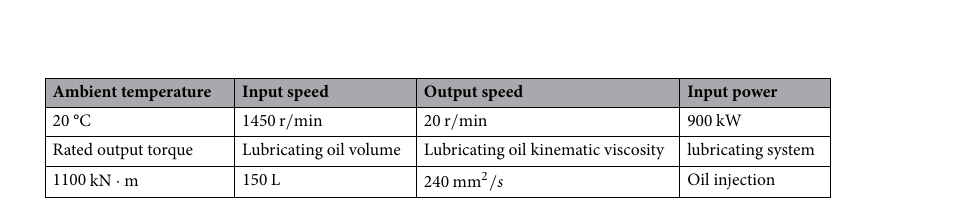
Figure 4. Training and testing performance curves.